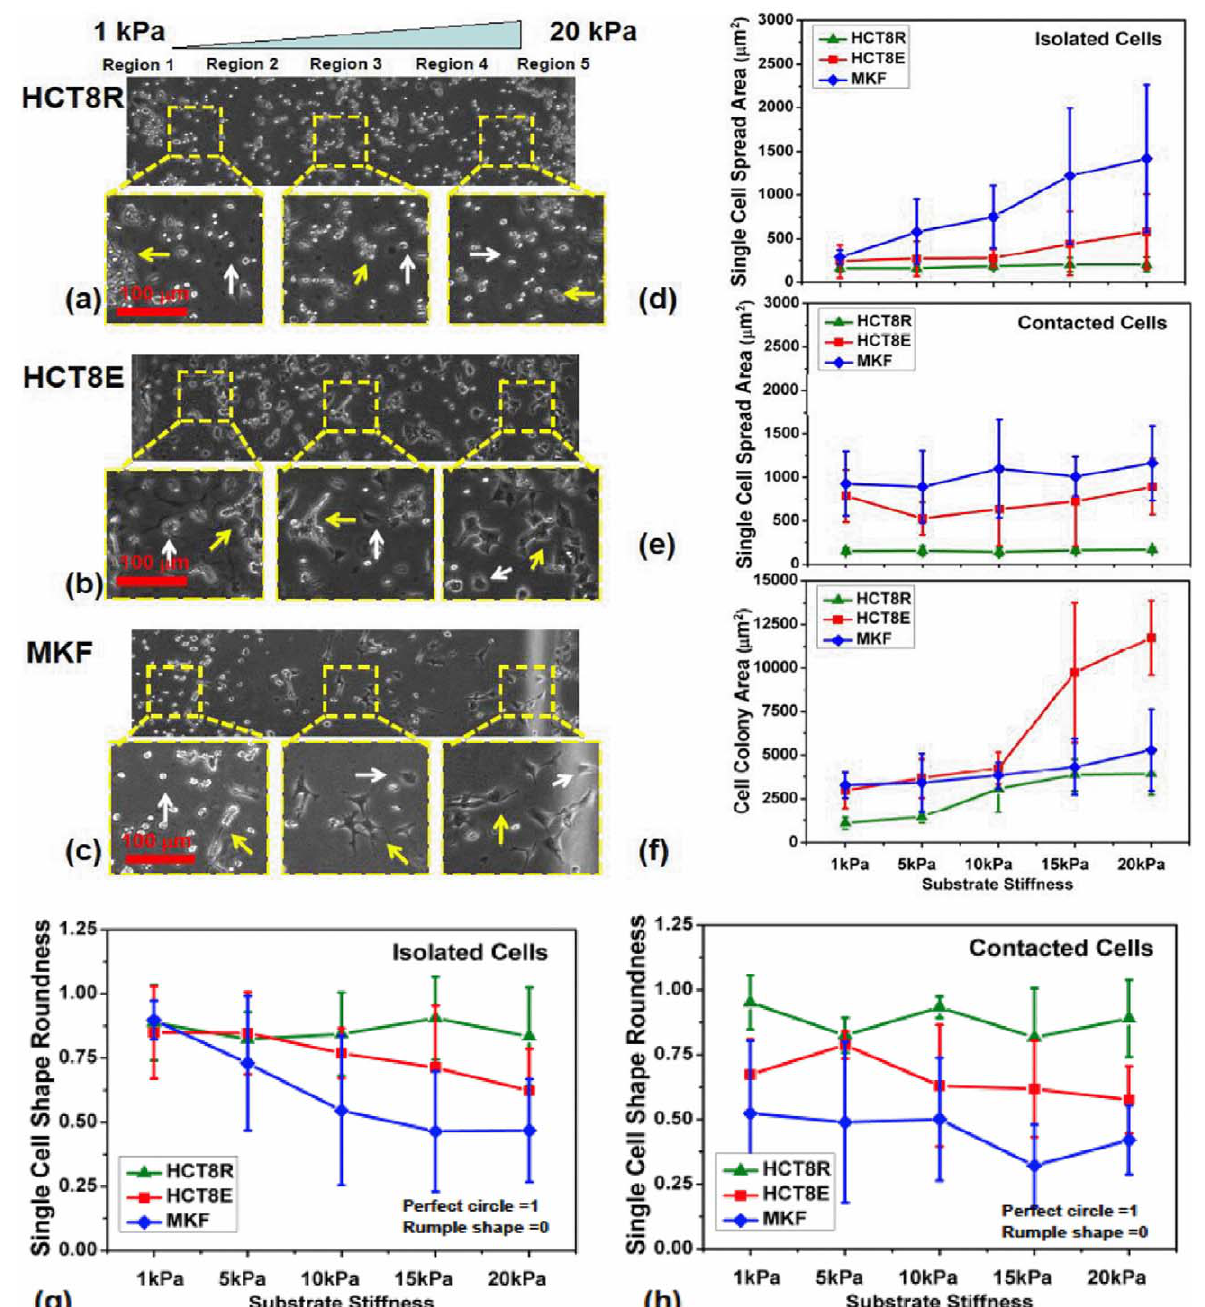
Figure 1. HCT-8 E and R cells and MKF cells cultured on stiffness-gradient PA substrates with stiffness varying continuously from 1 to 20 kPa (left to right). (a–c) Phase contrast images of the harvested HCT-8 R cells, HCT-8 E cells, and normal MKF cells on the gradient-stiffness PA gel substrates. The respective 3 square panels (enclosed by yellow dash boxes) show the representative magnified views on 1–5 kPa, 8–12 kPa, and 15–20 kPa stiffness domains. The white arrows in magnified views indicate the single, non-contact cells, while the yellow arrows indicate the contacting cells in colonies. Scale bars in magnified view panels are 100 m m. (d) The single cells’ projected area of 3 cell types across the stiffness range are shown. Here they do not have any contact with their neighboring cells on different stiffness substrates. (e) The spread area of single cells in contact with neighboring cells on different stiffness substrates. (f) The apparent cell colony area of 3 cell types on different stiffness substrates. (g) The cell shape factor of 3 cell types, which are not in contact with their neighboring cells on different stiffness substrates. (h) The cell shape factor of single cells, which are in contact with neighboring cells on different stiffness substrates. doi:10.1371/journal.pone.0050443.g001 and shape factor as those of isolated R cells, even when in contact compared to E cell islands consisting of similar cell numbers with neighboring cells (Fig. 1a, indicated by yellow arrows). This R (Fig. 1f). The individual cell areas and shape factors of single R cell phenotype results in generally smaller R cell colony area cells inside R cell colonies on 1 kPa gels are 151.8 6 33.4 m m 2 and